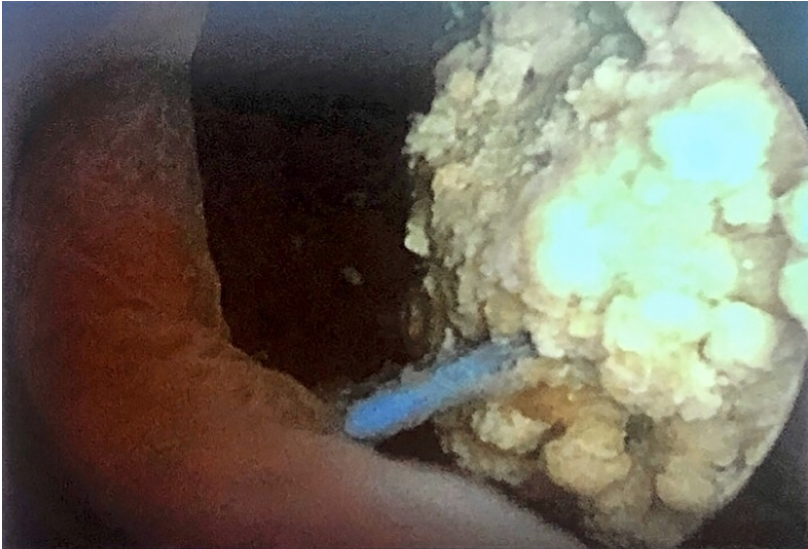
Figure 2 - Cystoscopy in a patient with dysuria and interrupted flow. Notice the blue thread (needle suspension) and the